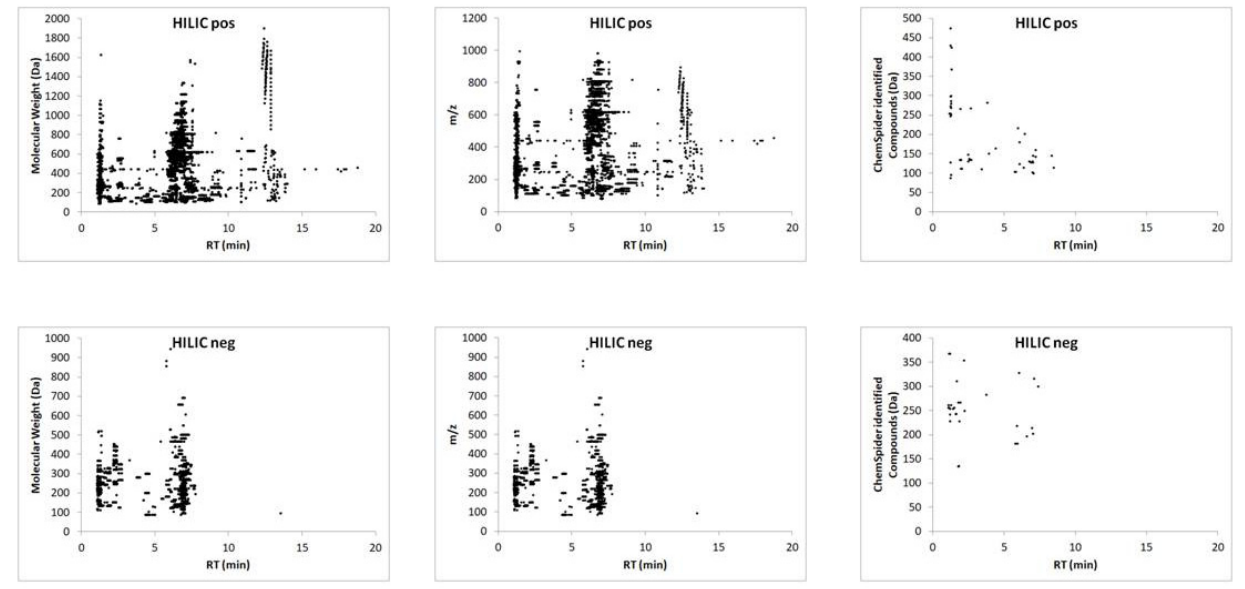
Figure 2. Ion map of extracted metabolites defined by molecular weight and m/z, and Chemspider- identified compounds from the PFP and HILIC column in positive and negative ionization mode followed by LC–MS